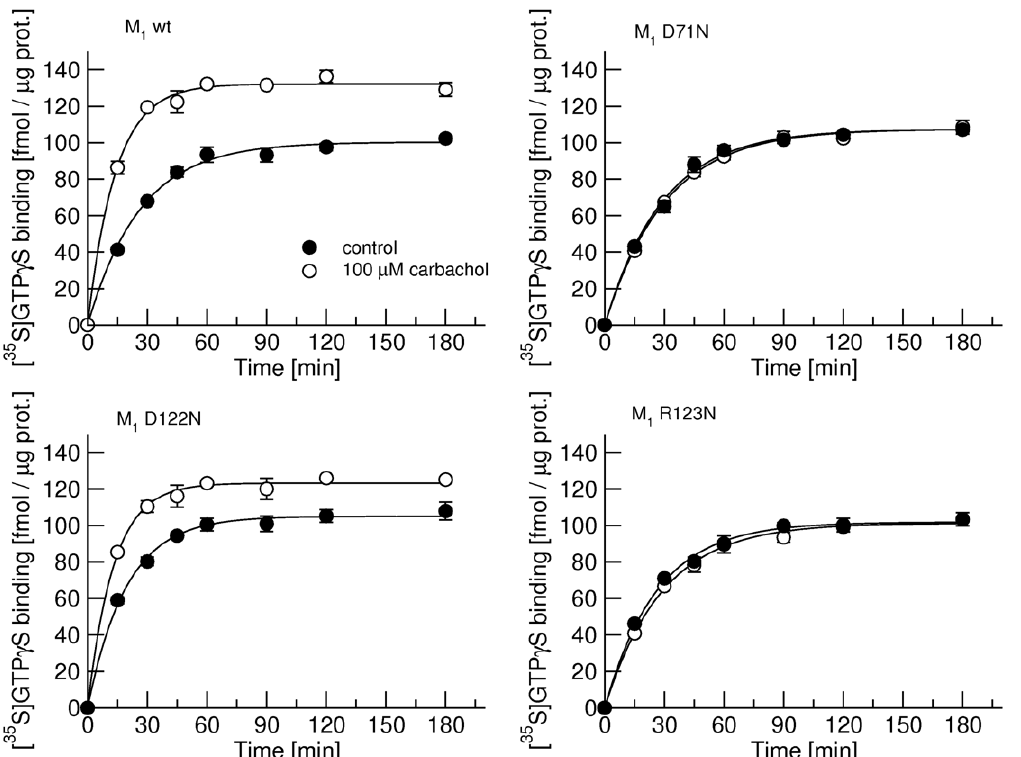
Figure 5. Effects of point mutations of the M 1 receptor on carbachol-induced stimulation of of [ 35 S]GTP c S. Binding of 0.5 nM [ 35 S]GTP c S to all G-proteins in the presence of 50 m M GDP was measured in membranes from newly prepared CHO cell lines expressing either wild- type (M 1 wt) or mutant (D71N, D122N, R123N) M 1 receptors in the absence (full circles) or in the presence (open circles) of 100 m M carbachol. Data are means 6 S.E.M of values from 3 experiments performed in quadruplicates. Curves were fitted using equation 4 and results of fits are shown in Table 5. doi:10.1371/journal.pone.0027732.g005 PLoS ONE |